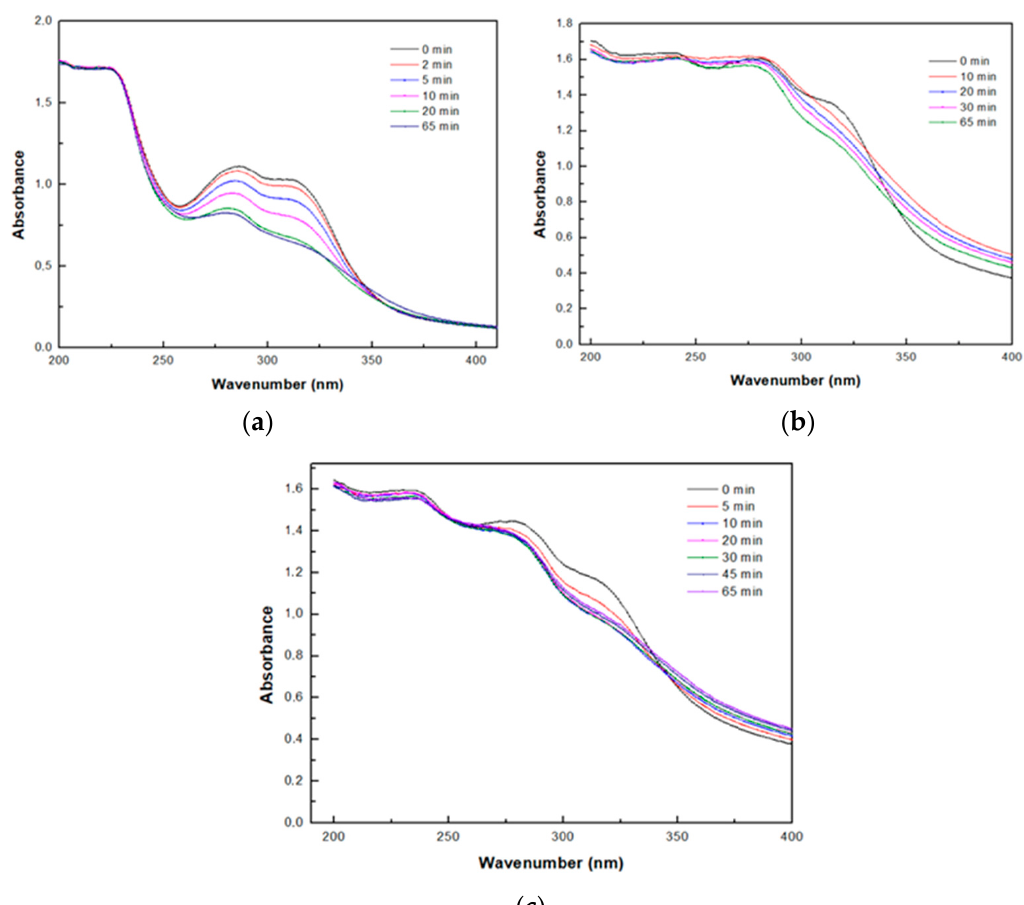
Figure 4. Changes in the UV spectra of the ferulic acid oxidation by laccase from Agaricus bisporus in the presence of: ( a ) chitosan; ( b ) chitosan–gelatin; and ( c ) CMC solutions.